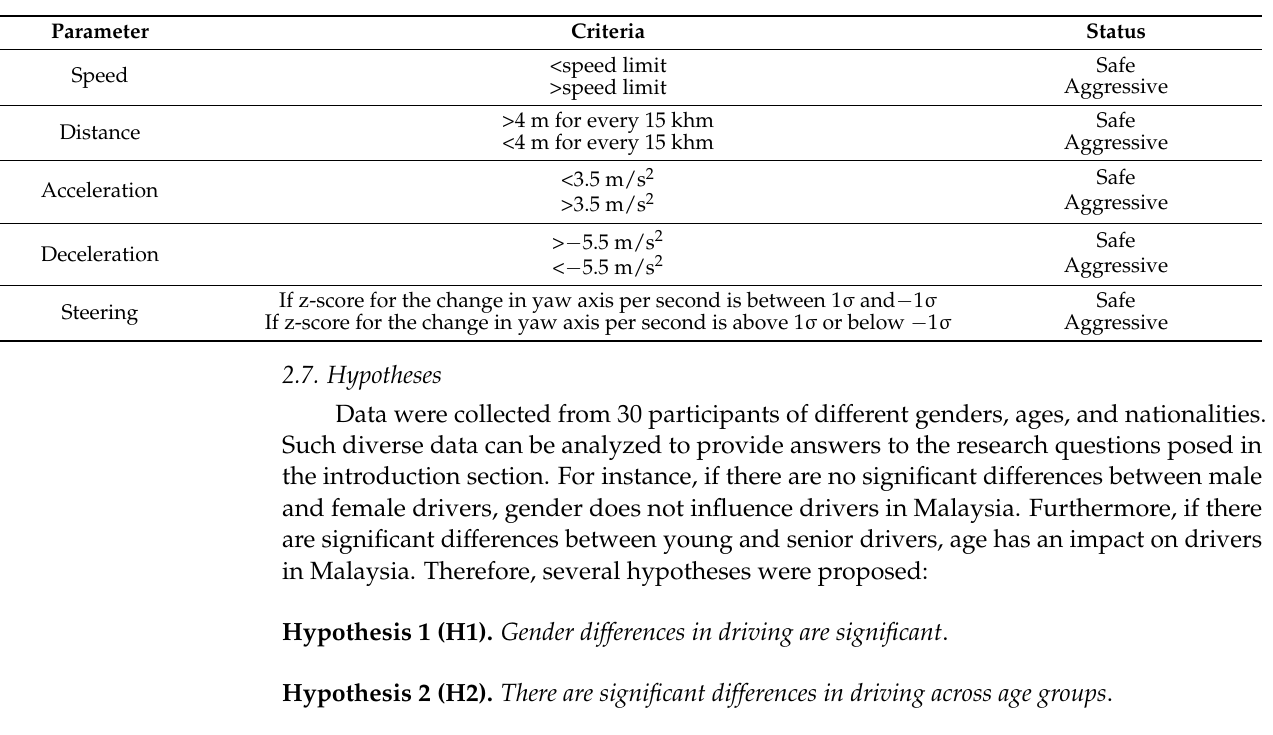
Table 3. Criteria for safe and aggressive